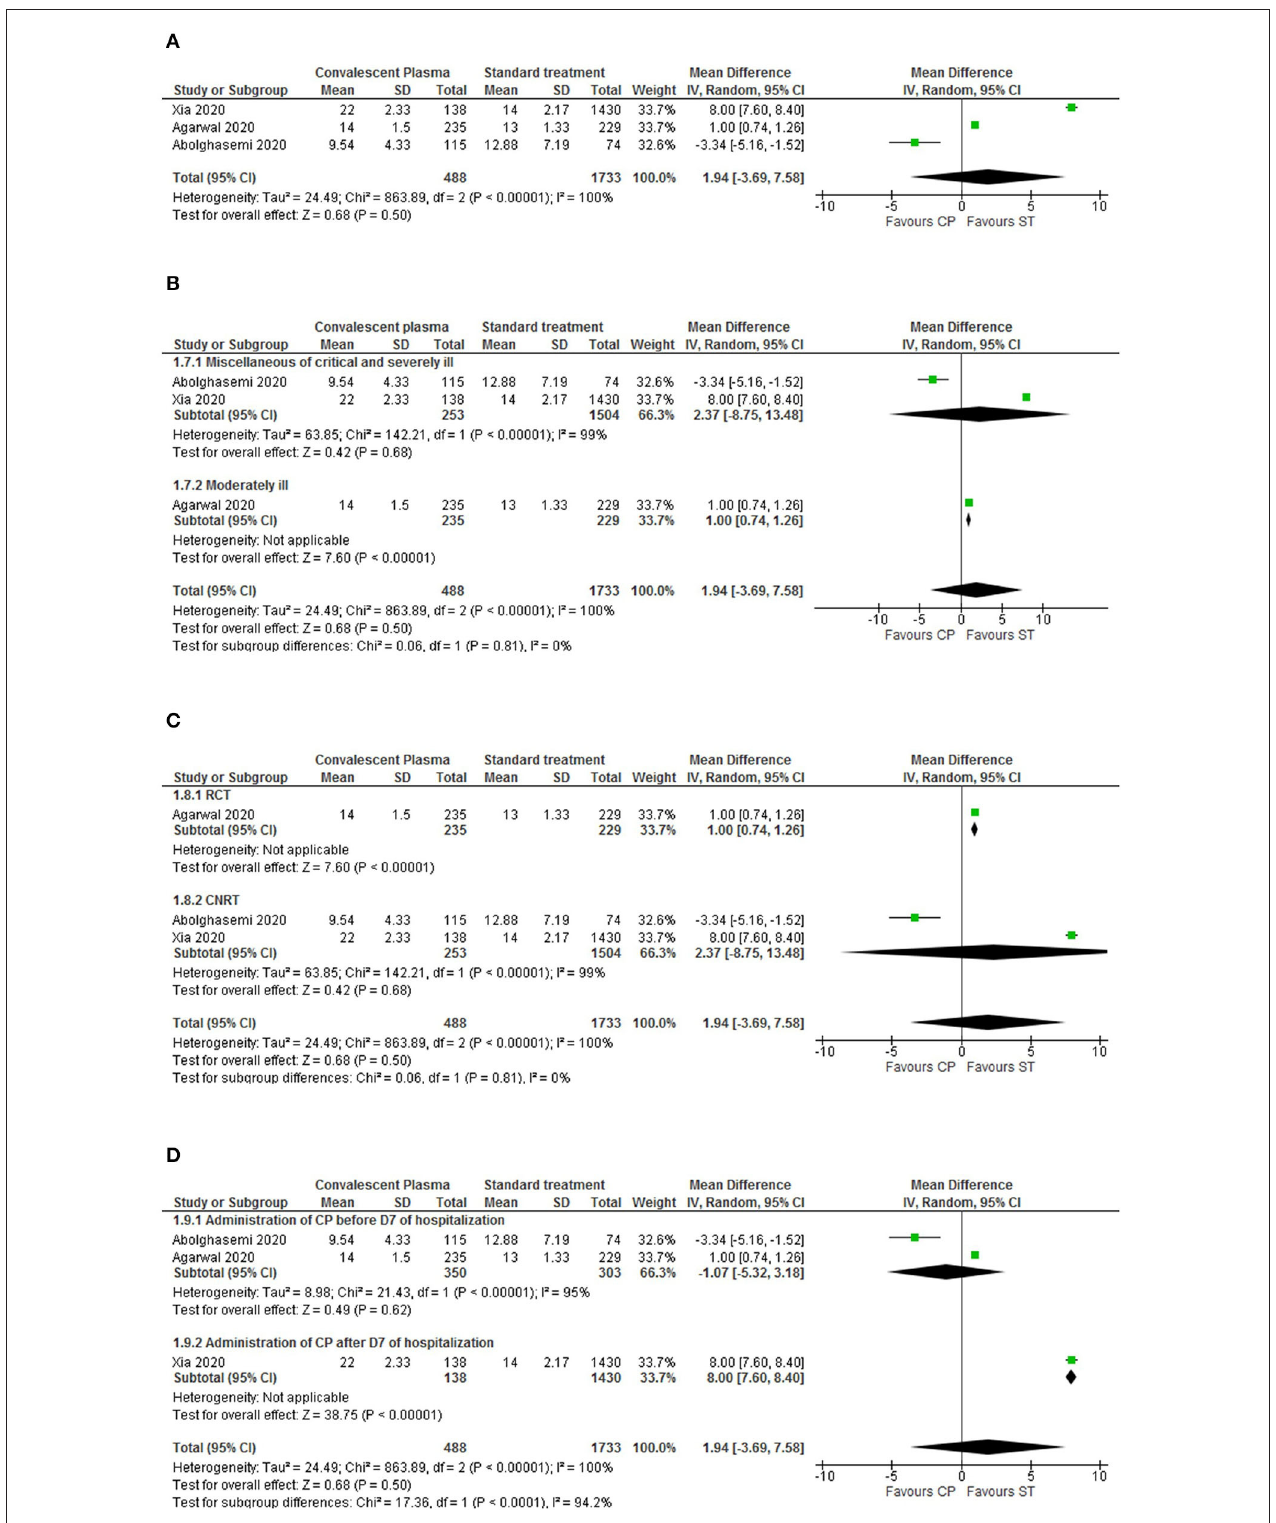
FIGURE 4 | Forest plots for length of hospitalization analysis and sub-analysis assessing CP intervention and standard treatment. (A) Beginning at hospital admission, the hospitalization length results showed a significantly decreased period of hospital stay for the standard treatment. However, the overall heterogeneity levels